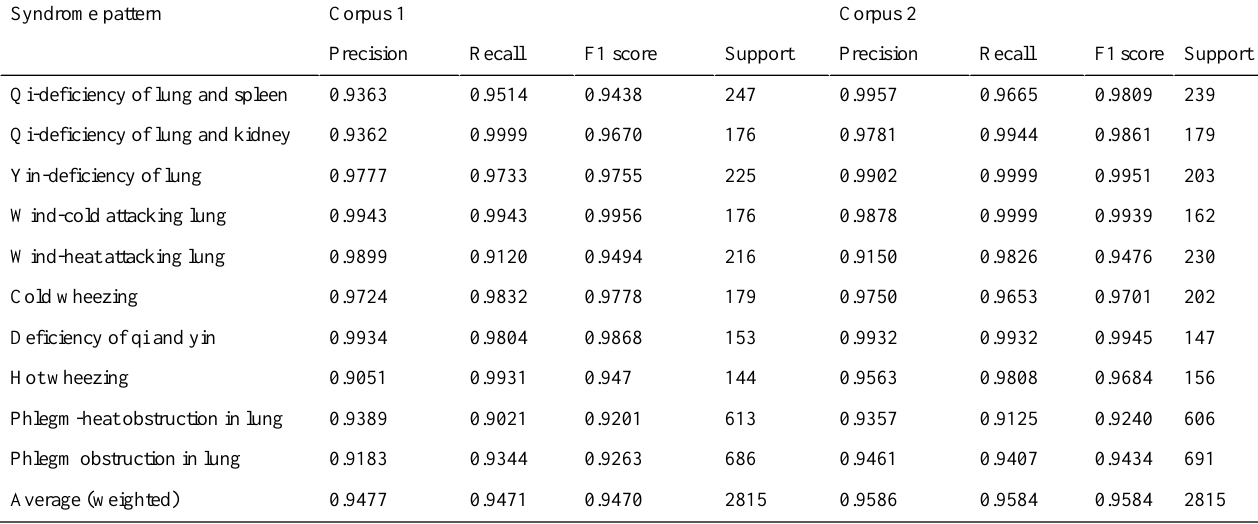
a Corpus 1 consists of syndrome and sign information, and corpus 2 consists of syndrome and sign information plus clinical diagnosis information. The average accuracy was 0.9471 (95% CI 0.9382-0.9549) for syndrome pattern in the test data set with corpus 1, and 0.9584 (95% CI 0.9510-0.9655) for syndrome pattern in the test data set with corpus